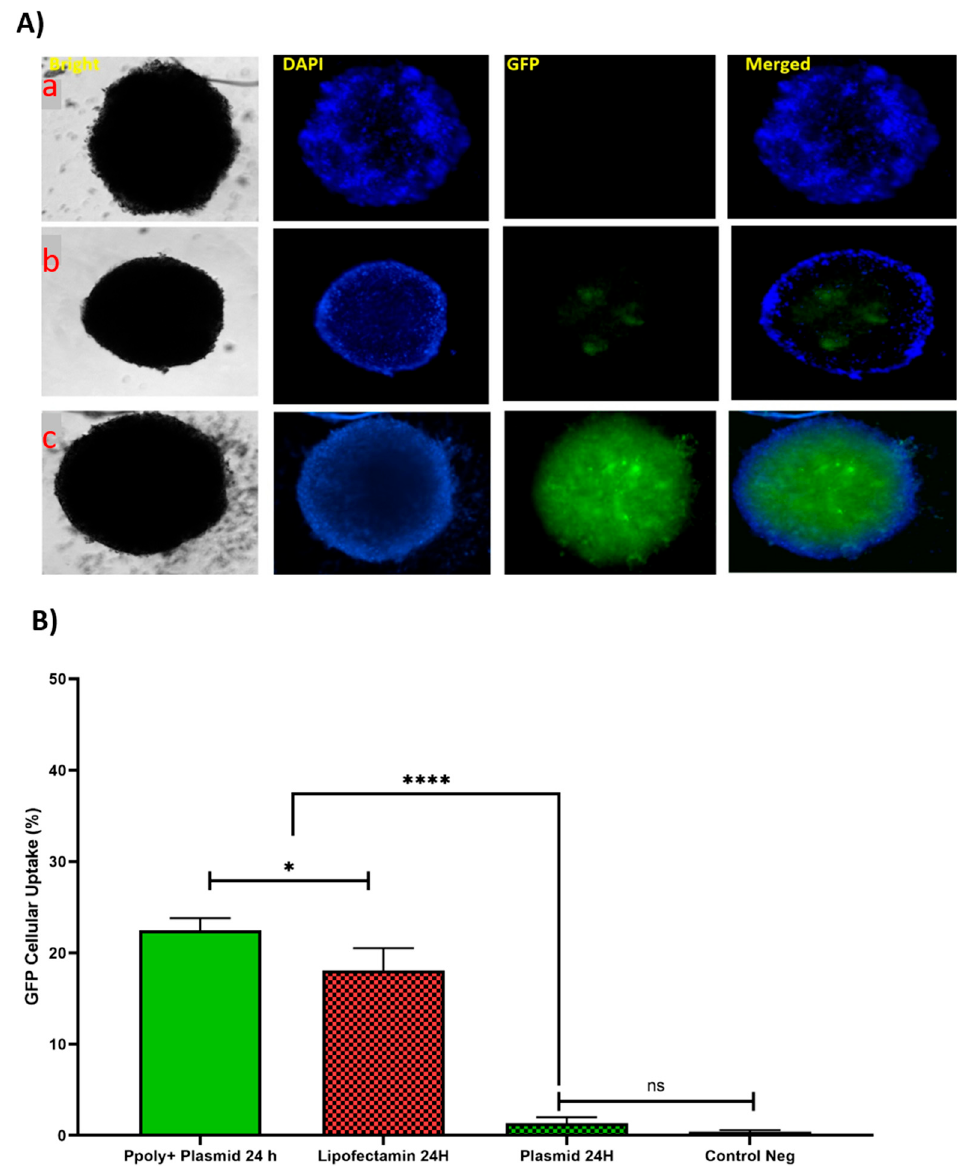
Figure 7. ( A ) Microscopic fluorescent images of 3D spheroids with PPoly/pEGFP nanocomplexes transfection at an N/P ratio of 25:1 ( c ) in comparison with free pDNA ( a ) and lipofectamine ( b ) after 24 h incubation. ( B ) Quantitative transfection efficacy (%) determined by the EGFP content as assessed by FACS analysis of 3D cells treated with PPoly/pEGFP nanocomplexes at an N/P ratio of 25:1 in comparison with free pDNA and lipofectamine after 24 h incubation. Representative measurements of three independent experiments are reported. The p -values are indicated as * <0.05, **** <0.0001, and ns (not